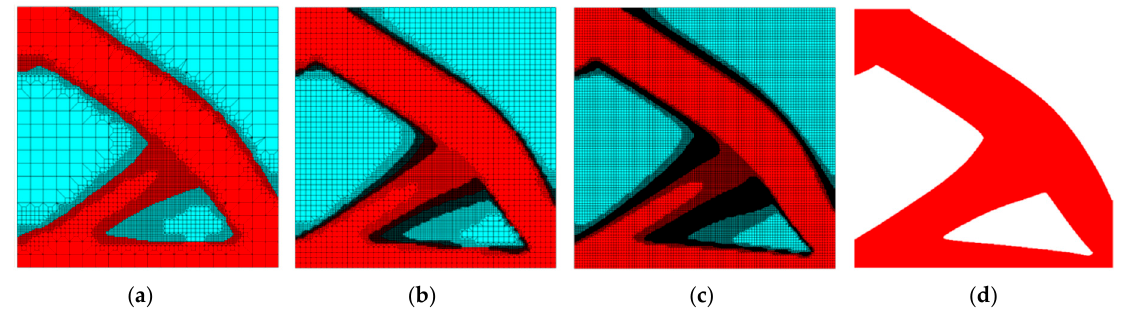
Figure 12. Final topologies obtained for four sizes of initial elements: 0.0025 m 2 ( a ), 0.0004 m 2 ( b ), 0.0001 m 2 ( c ) and ~4.726 × 10 − 6 m 2 regular mesh ( d ). For the last case the grid has not been shown to improve the clarity of the picture.